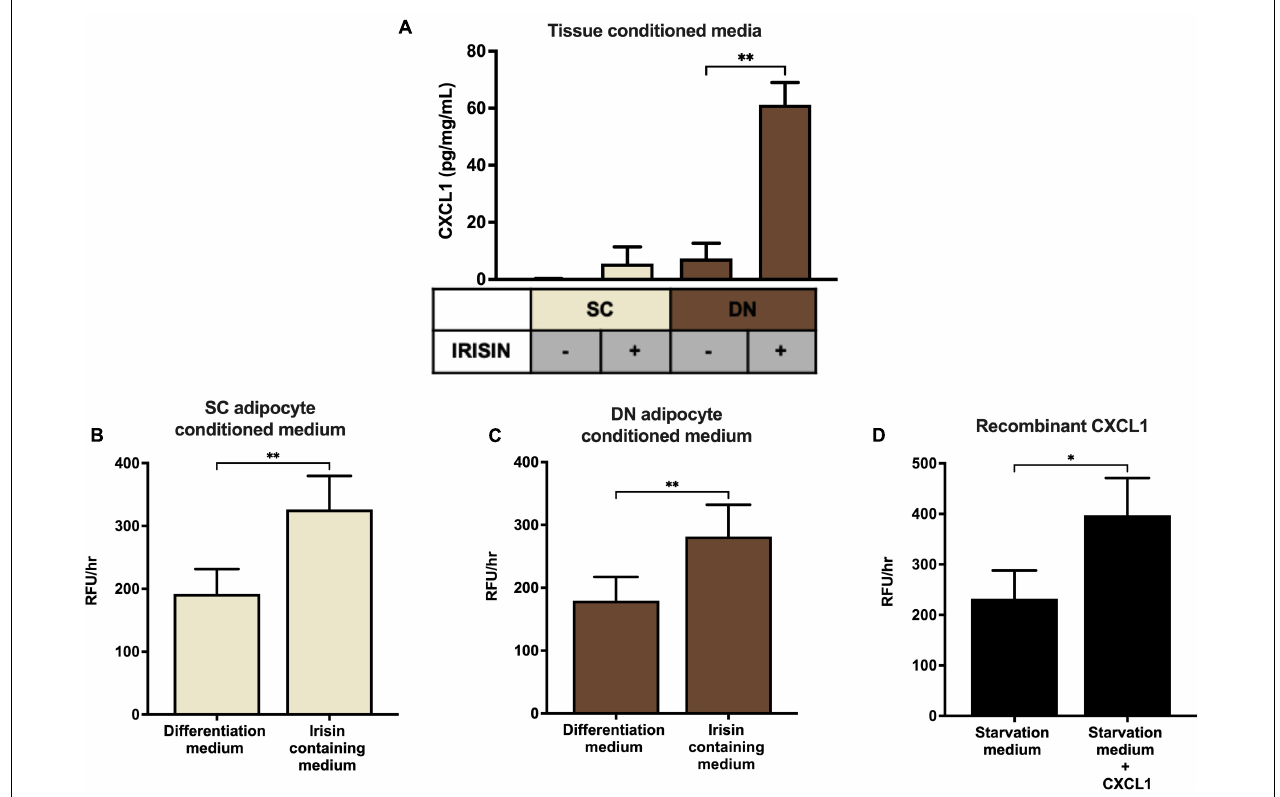
FIGURE 6 | Irisin stimulated the release of CXCL1 from deep-neck (DN) tissue biopsies, which improves the adhesion property of endothelial cells. (A) CXCL1 released into the conditioned media of paired subcutaneous (SC) and DN biopsies after 24 h incubation in the presence or absence of irisin ( n = 4), Quantification of adhesion of endothelial cells upon incubation with the conditioned media (with or without irisin treatment) from ex vivo differentiated (incubation period from day 8–12 of differentiation) SC (B) and DN (C) area adipocytes ( n = 5), (D) Quantification of endothelial cell adhesion upon incubation with recombinant CXCL1 in starvation medium ( n = 3). Data presented as Mean ± SD. ∗ p < 0.05, ∗∗ p < 0.01. Statistics: One-way ANOVA with Tukey’s post-test (A) and Welch’s t -test (B–D)